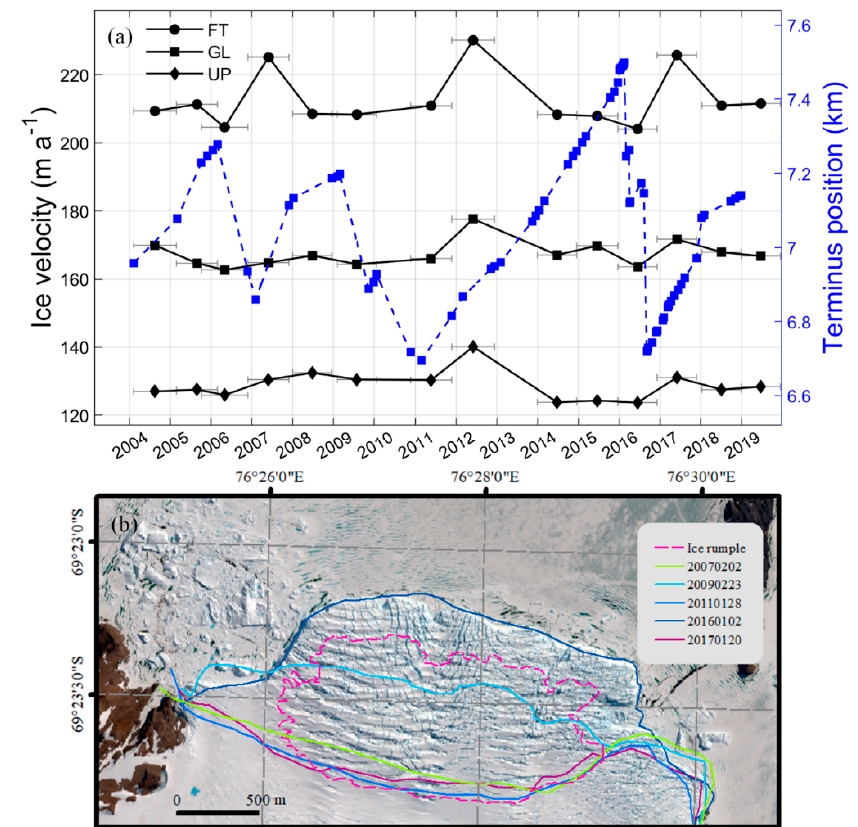
Figure 8. Link between terminus change, velocity variation, and ice rumple. ( a ) Terminus changes and velocity variations of Dalk Glacier in 2004–2017. Short grey lines donate the overlay time of image pairs used in velocity calculation. ( b ) Positions of glacier terminus and the ice rumple. The pink dotted line shows the possible range of the ice rumple. Colored solid lines are the maximum and minimum glacier extents for each advance and retreat phase.